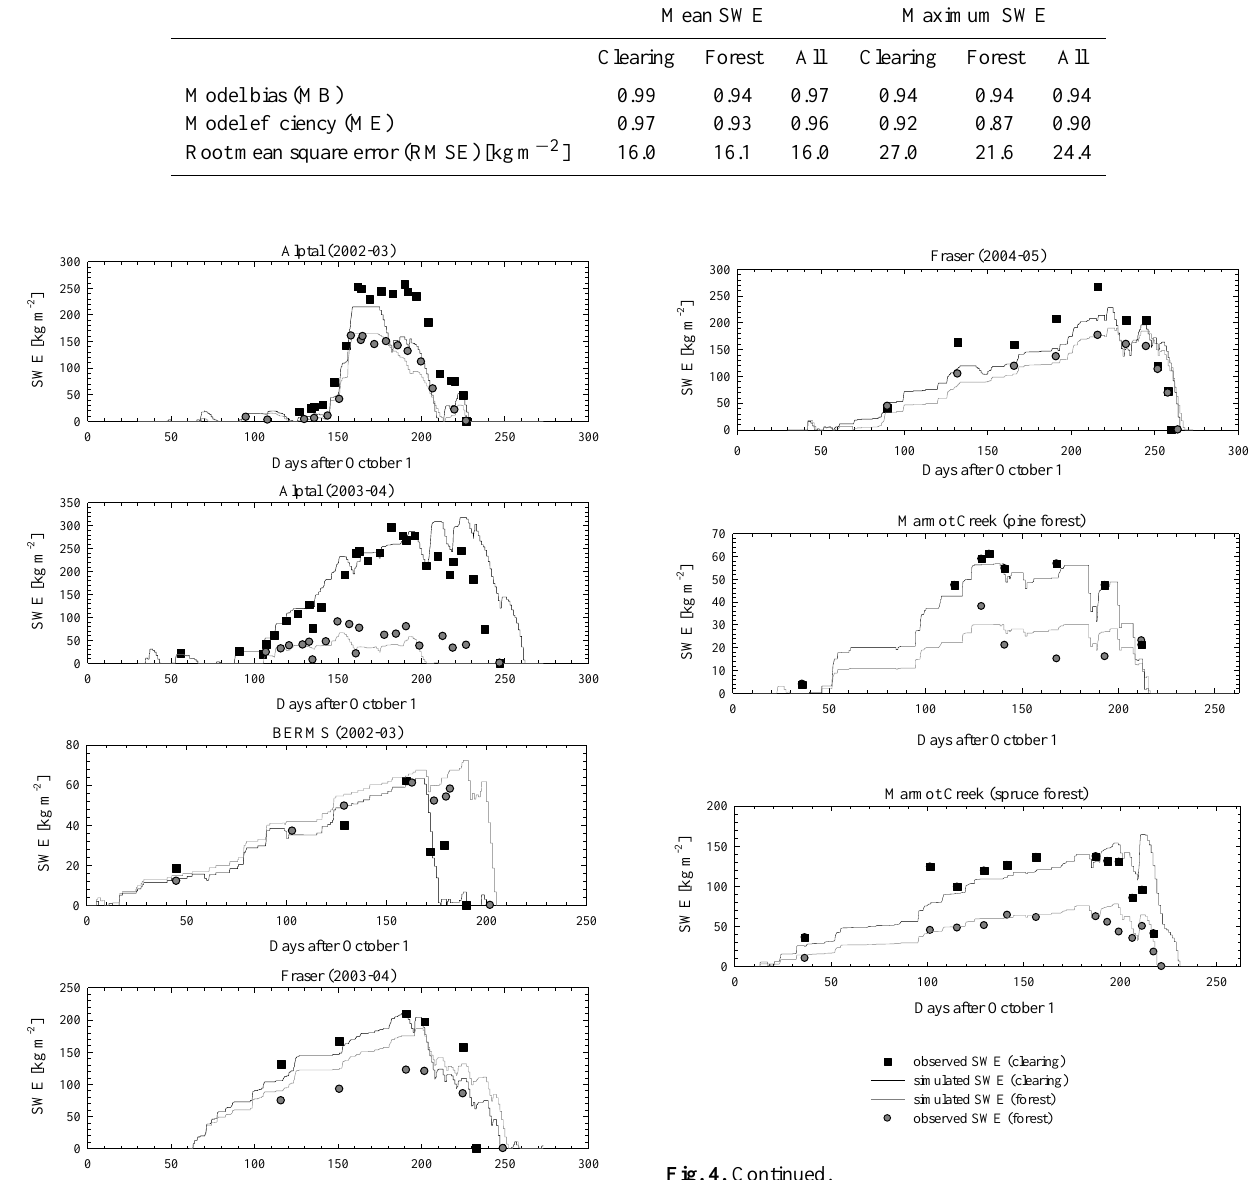
Fig. 4. Time series of observed and simulated SWE at paired forest and clearing sites.